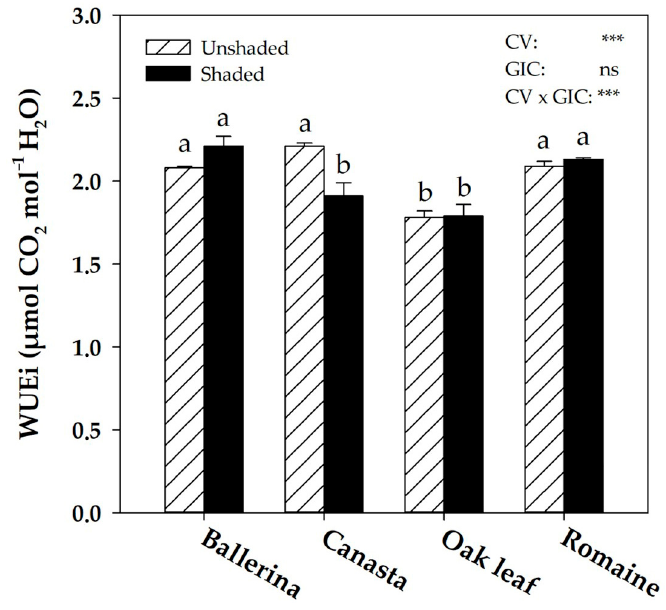
Figure 1. Effect of Cultivar (CV) and Greenhouse Irradiance Conditions (GIC) on instantaneous water use efficiency (WUEi) in Lactuca sativa L. Data are mean values ± standard error, n = 3. Mean comparisons were performed by Duncan’s Multiple Range Test (DMRT) for CV and by t -Test for GIC. Different letters indicate significant differences compared by DMRT ( p = 0.05). ns and *** denote nonsignificant or significant effect at p ≤ 0.001, respectively.